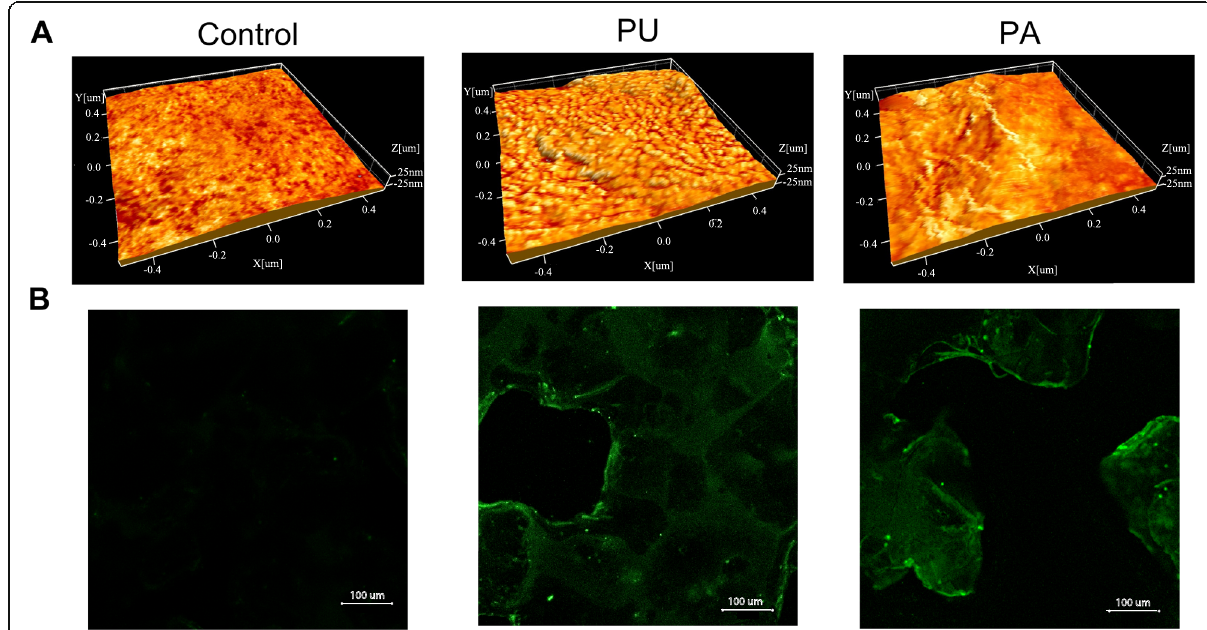
Fig. 1 ( A ) Representative 3D images of unfunctionalized PLCA (Control), PU functionalized PLCA (PU), PA functionalized PLCA (PA) measured with intermittent imaging technique, multimode atomic force microscopy (AFM) 1 μ m Å ~ 1 μ m with height range (topographical Peak-Valley) of approximately 50 nm and 512 × 512 pixels, corresponding to a theoretical lateral resolution of approximately 2 nm. PU, potato unmodified; PA, potato dearabinated; PLCA, poly( L -lactide-co- ɛ -caprolactone). ( B ) Representative confocal images of unfunctionalized PLCA scaffold (Control), functionalized PLCA scaffold with PU (PU), and functionalized with PA